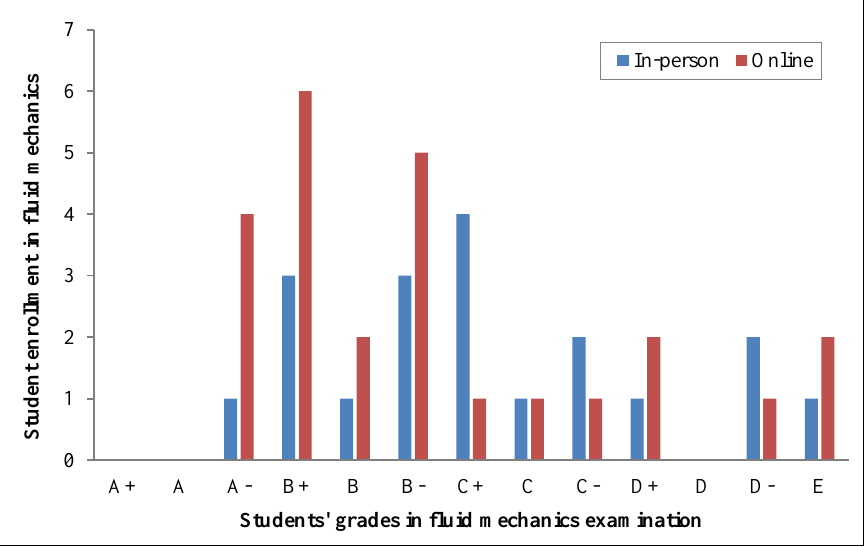
Figure 2. Grade distribution in Fluid Mechanics course in virtual and in-person learning